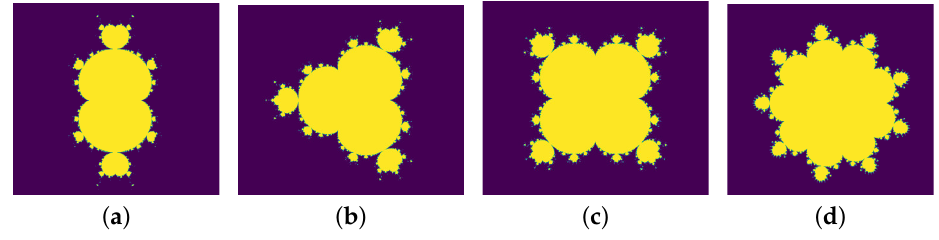
Figure 2. Generalized Mandelbrot Sets for ( a ) n = 3 ( b ) n = 4, ( c ) n = 5 and ( d ) n =